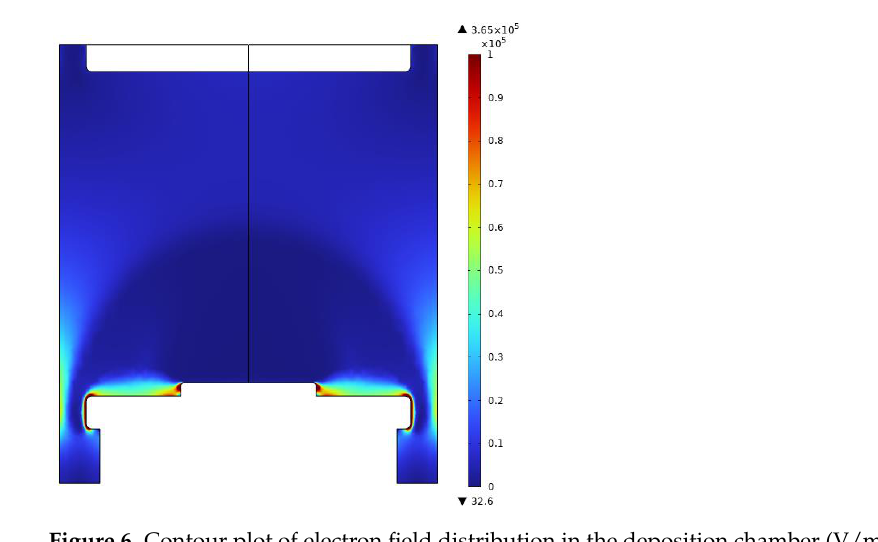
Figure 6. Contour plot of electron field distribution in the deposition chamber (V/m).